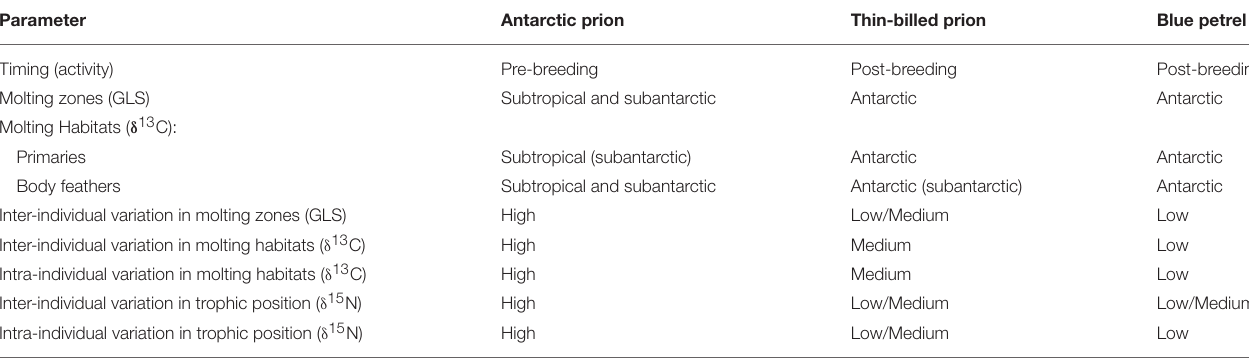
TABLE 5 | Summary of molt characteristics of prions and blue petrels from Kerguelen